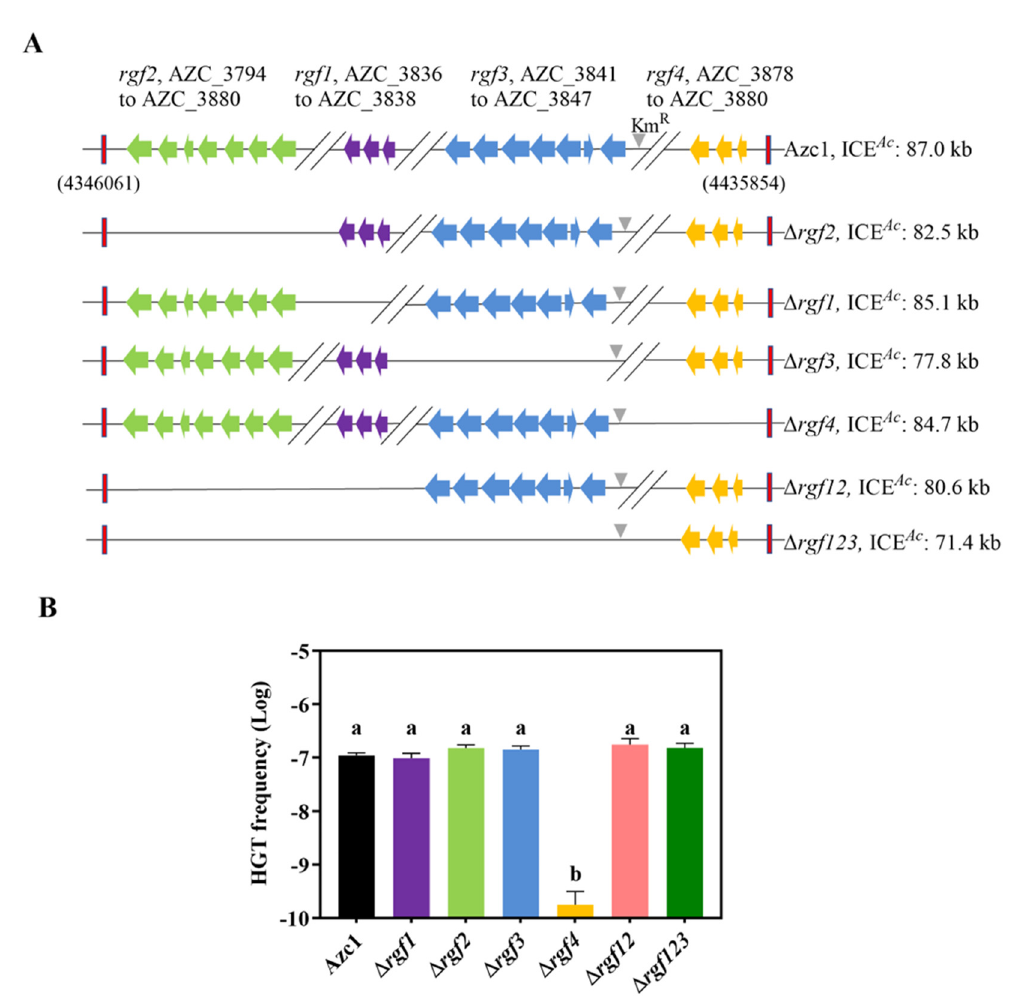
Figure 1. Differential consequences of rgf mutants on ICE Ac HGT frequency. ( A ) Distribution of 4 hypothetical rgf regions in ICE Ac , with a deletion strategy starting from the second row down. Red rectangles represent the entire ICE Ac region. The grey triangle represents the kanamycin-resistant gene, and other colors indicate different hypothetical rgfs . ( B ) Identification of rgf4 is required for ICE Ac HGT frequency. Azc1 (wild-type) or mutants were mixed with M. huakuii 93 at 28 °C, respectively. The colony-forming units (CFUs) of transconjugants and the recipient were determined to calculate the HGT frequency. Data are mean ± SD of three independent experiments. Means not connected by the same letter are significantly different ( p < 0.05).